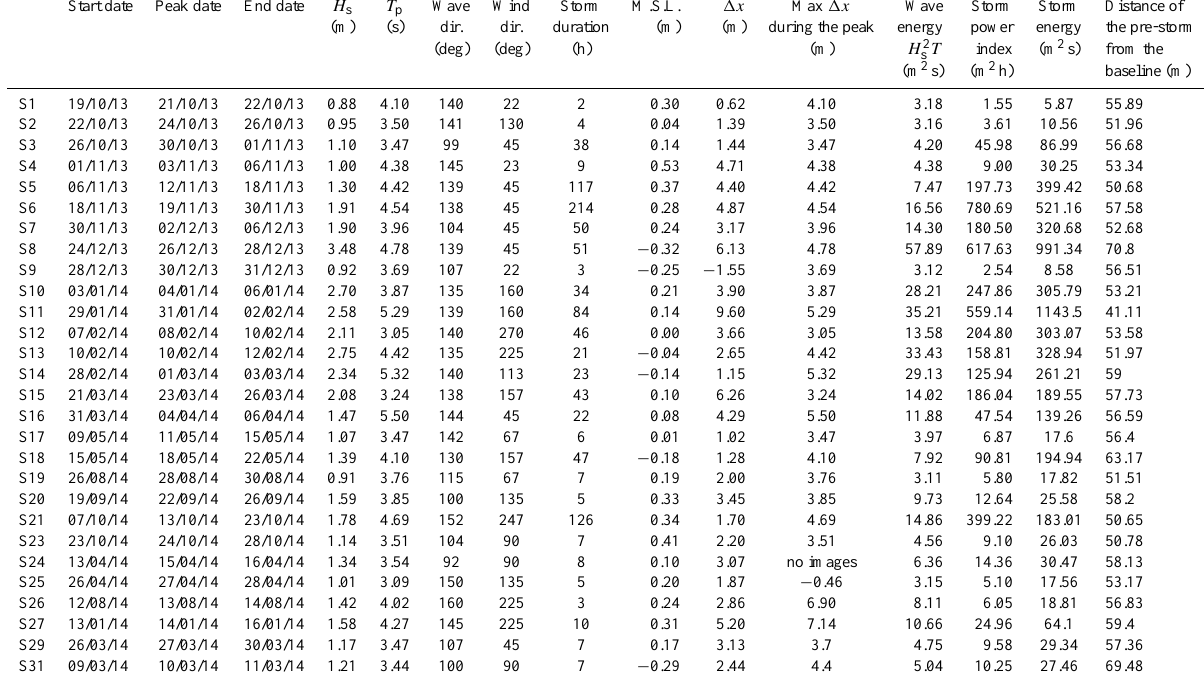
Table 1. List of the storm selected in the period October 2013–October 2014. Start date Peak date End